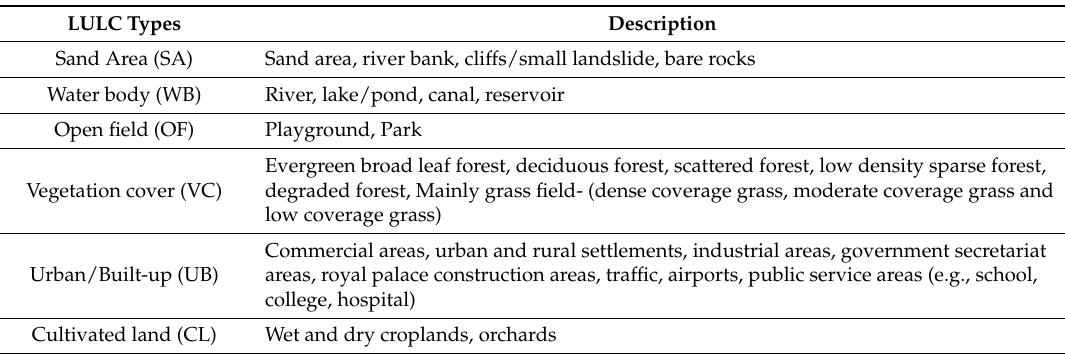
Table 2. Land-cover classification